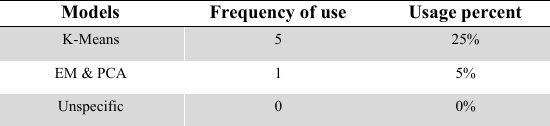
Fig. 16. Comparison of the clustering